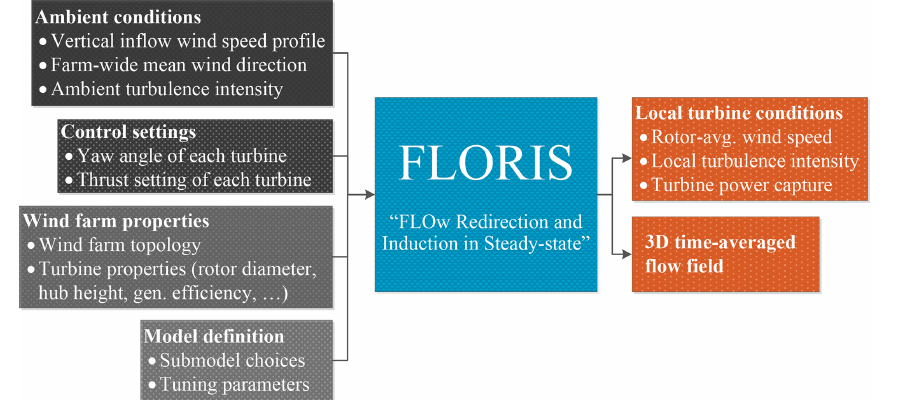
Figure 5. Flowchart of the FLORIS model. This model has four classes of inputs: the ambient conditions, a set of model parameters, the turbine control settings, and the wind farm properties (e.g., layout). FLORIS maps these inputs in a static fashion to a set of turbine outputs including the power capture and the three-dimensional flow field.